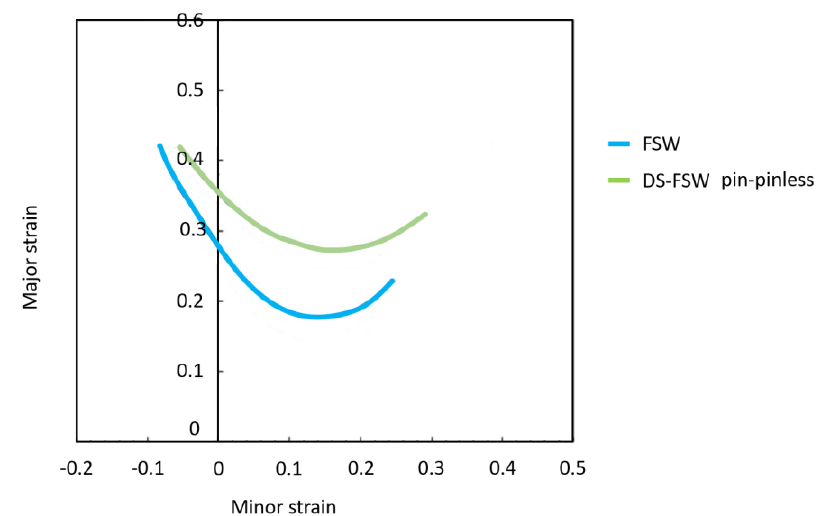
Figure 10. The e ff ect of welding methodology process, and a sample arrangement of welded joints Figure 10. The effect of welding methodology process, and a sample arrangement of welded joints versus base material on forming limit curves. versus base material on forming limit curves.